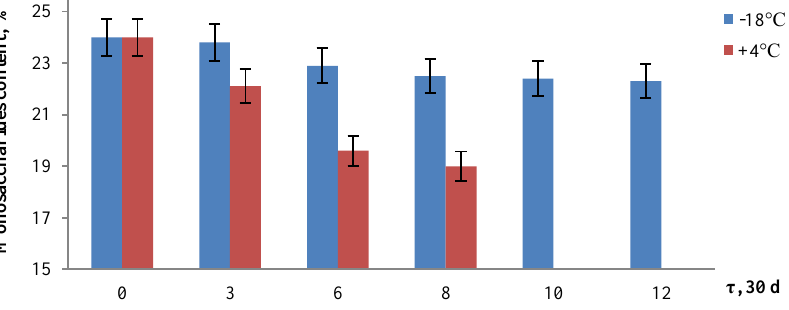
Fig. 3. Monosacharides content of dates during storage at +4 °C and −18